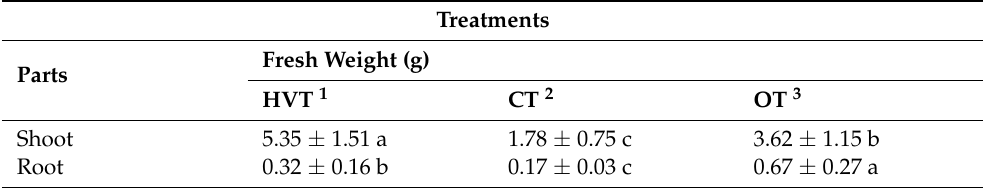
Table 1. Average and standard deviation of the fresh weight for Pak choi for each